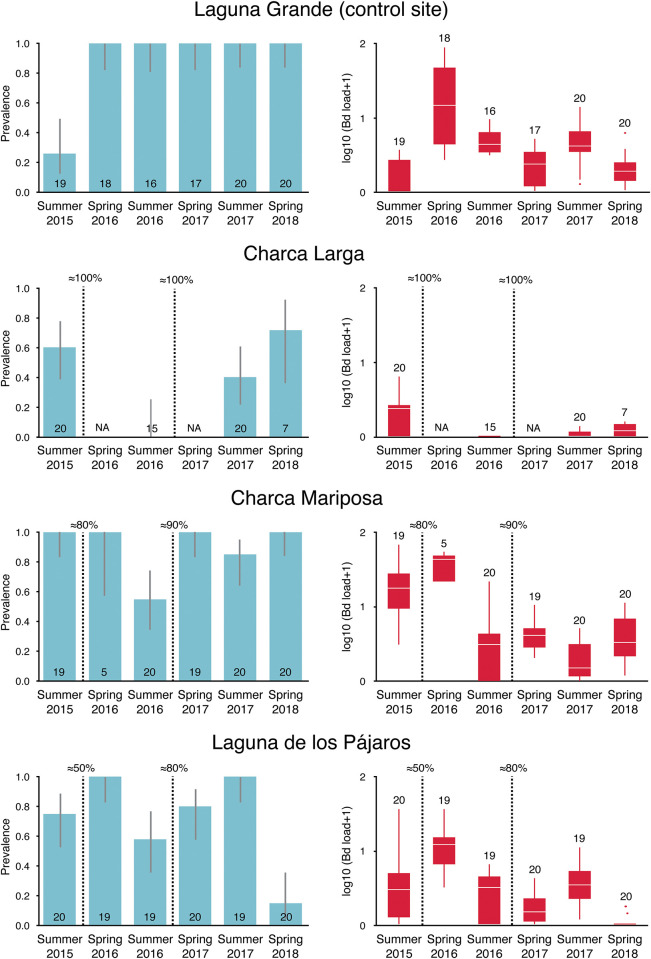
Pond specific changes in prevalence (left, vertical lines are 95% confident intervals) and load (right, in log transformed ZE values; horizontal lines depict medians, boxes represent interquartile ranges, whiskers extend to minima-maxima and dots show potential outliers) of Bd in salamander larvae (numbers above each bar or box-plot are sample sizes; n = 392 for both prevalence and infection intensity) within the Guadarrama National Park, Central Spain, 2015–2018.Dashed vertical lines indicate date (the end of the summer of the previous year and/or the early spring of the current year) and the approximate total proportion of larvae removed. Laguna Grande acted as control pond where no larvae were removed.